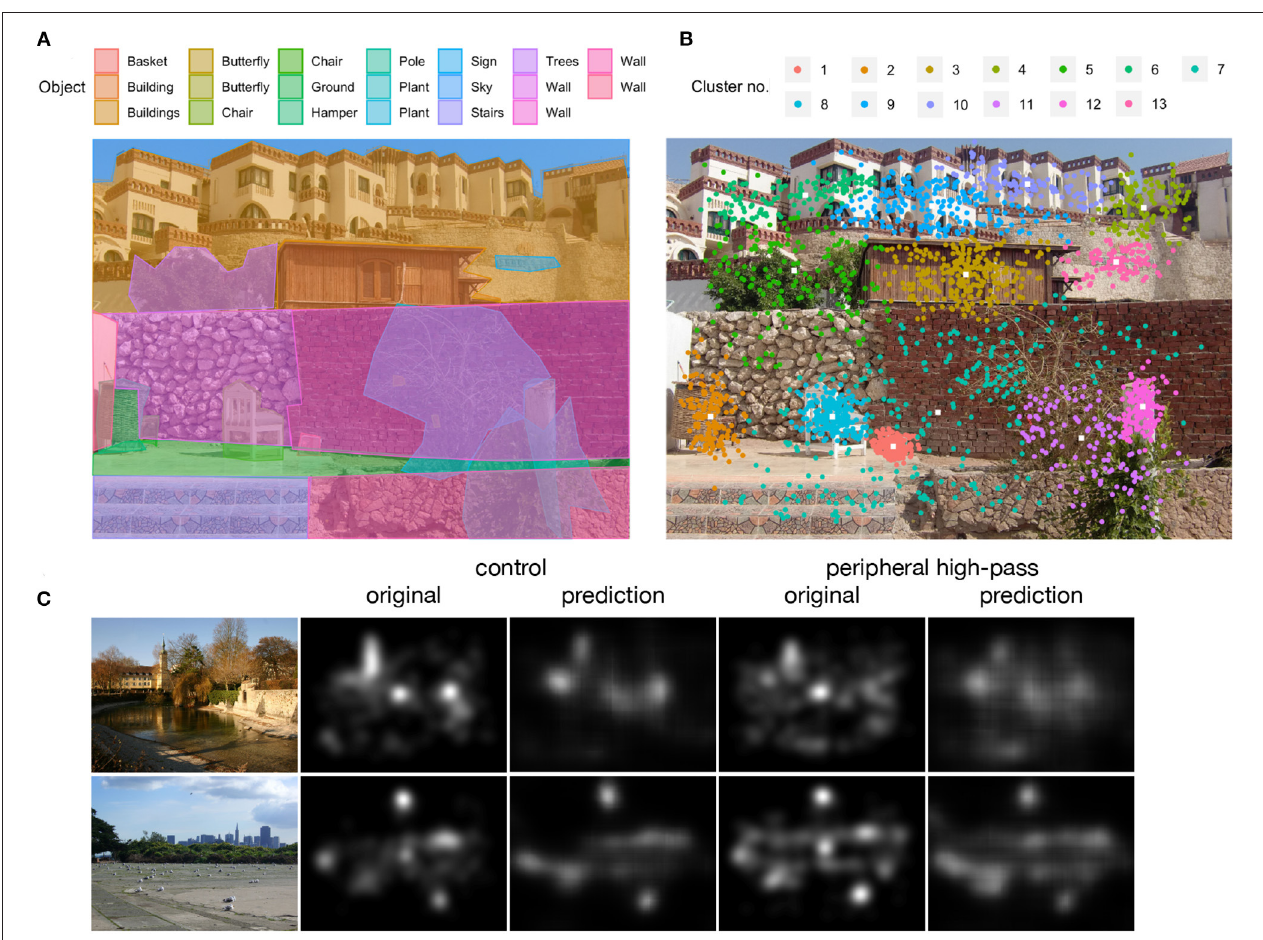
FIGURE 1 | Illustration of object annotations, fixation clusters, and heatmaps for scenes from the memorization task. (A) Scene with manually drawn polygons outlining individual objects or object groups with corresponding object labels. (B) Fixation clusters based on empirical fixation positions across all participants and spatial-frequency filter conditions on the color version of the scene. (C) Exemplary heatmaps of fixation distributions for the control condition (no filtering) and peripheral high-pass filtering based on empirical fixation positions across all participants and color conditions ( original ) and on predictions of a convolutional neural network model for that fixation distribution ( prediction ). White color indicates the highest and black color indicates the lowest density of